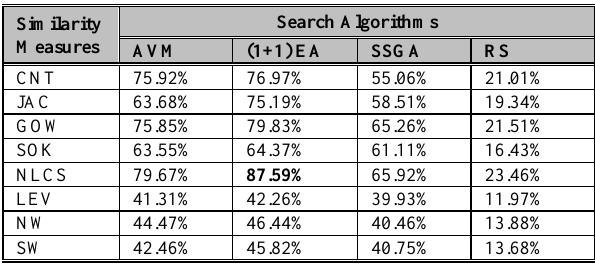
Table 3. ReliabilityPercentage Values of Each Combination of the Similarity Functions and Search Algorithms Similarity